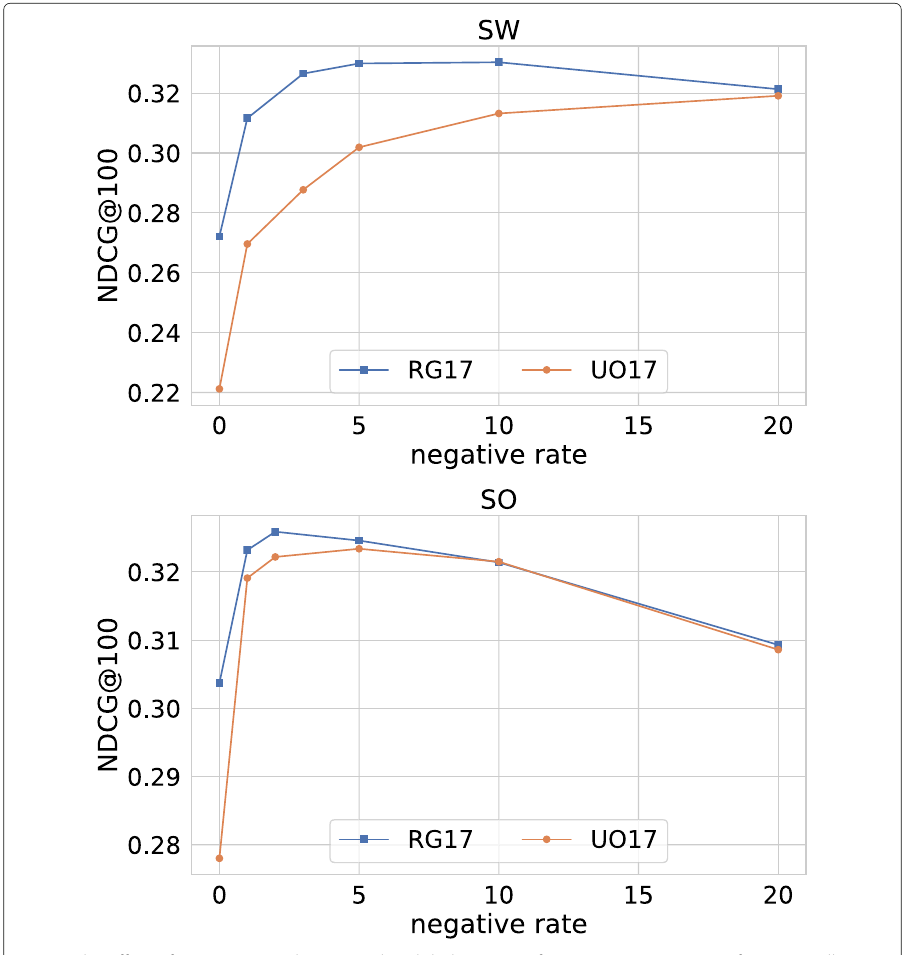
Fig. 8 The effect of negative sample rate on the global mean performance (NDCG@100) of StreamWalk ( top ) and online second order similarity ( bottom